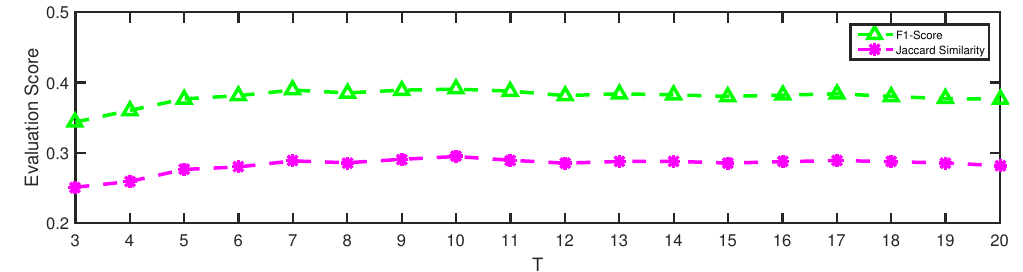
Figure 7. Varying the iteration number t from 3 to 20 with r = 3 on the Facebook dataset.